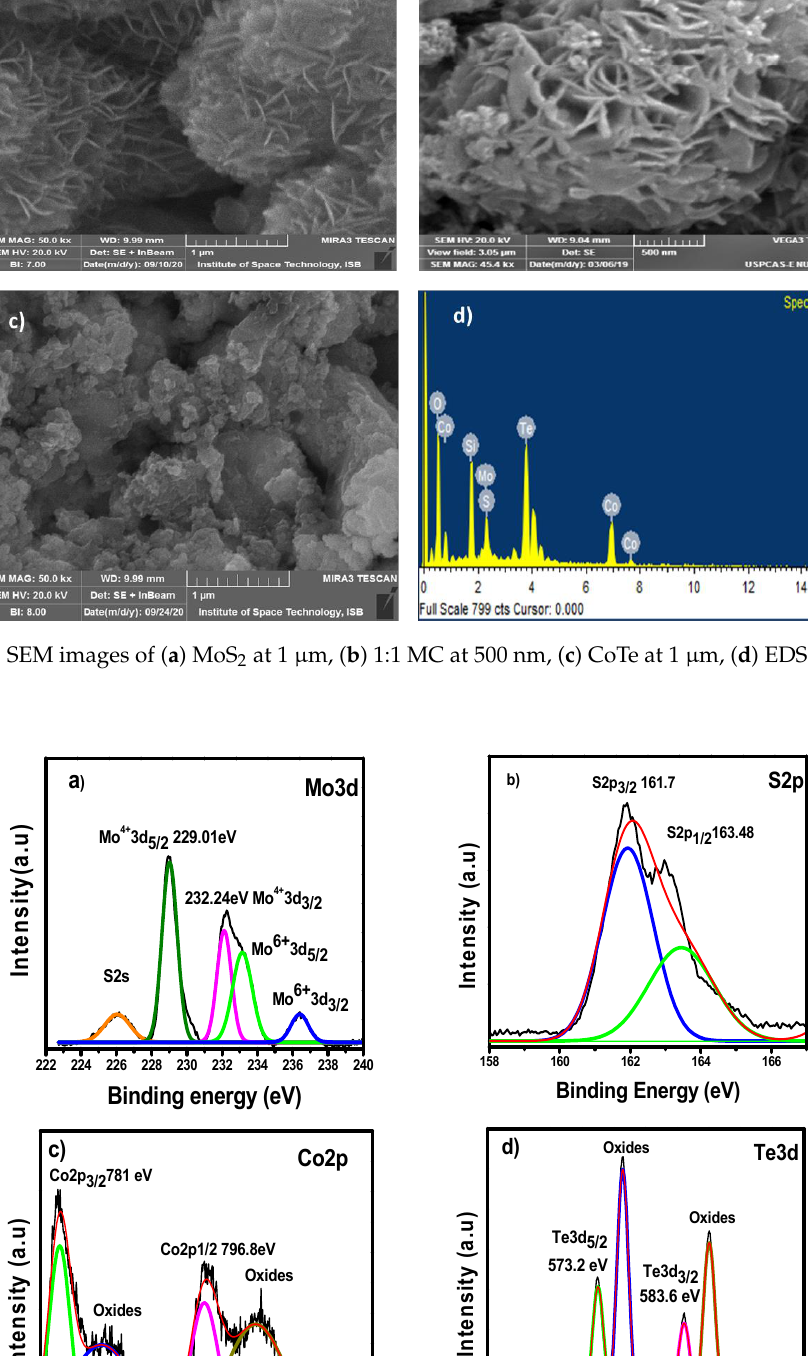
Figure 3. XPS spectra of MoS 2 ( a ) Mo3d, ( b ) S2p and CoTe ( c ) Co2p, ( d ) Te3d.